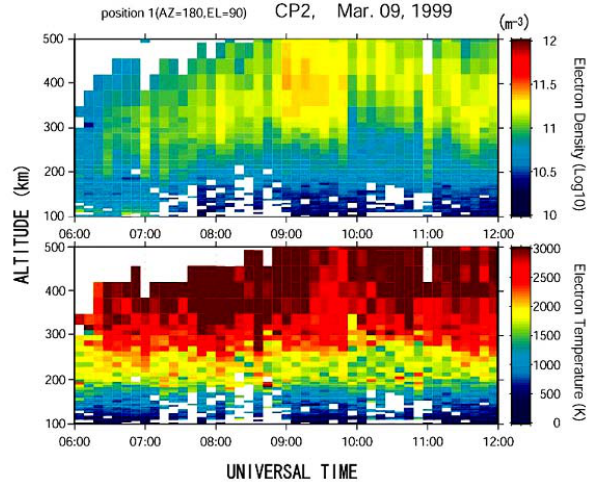
Fig. 5. The electron density (upper) and temperature (lower) de- rived from the ESR observations during 06:00–12:00 UT. Note that the electron density is displayed with logarithmic